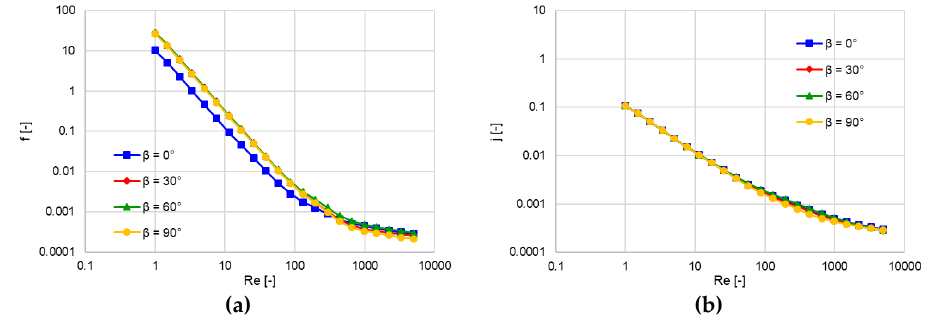
Figure 13. REV characterization for the dimple-type turbulator: ( a ) Calculation of the Fanning friction factor as a function on Re number and flow angle; ( b ) calculation of the Colburn factor as a function on Re number and flow angle. Results are normalized with respect to a reference value (the maximum value of the offset-strip fins dataset).